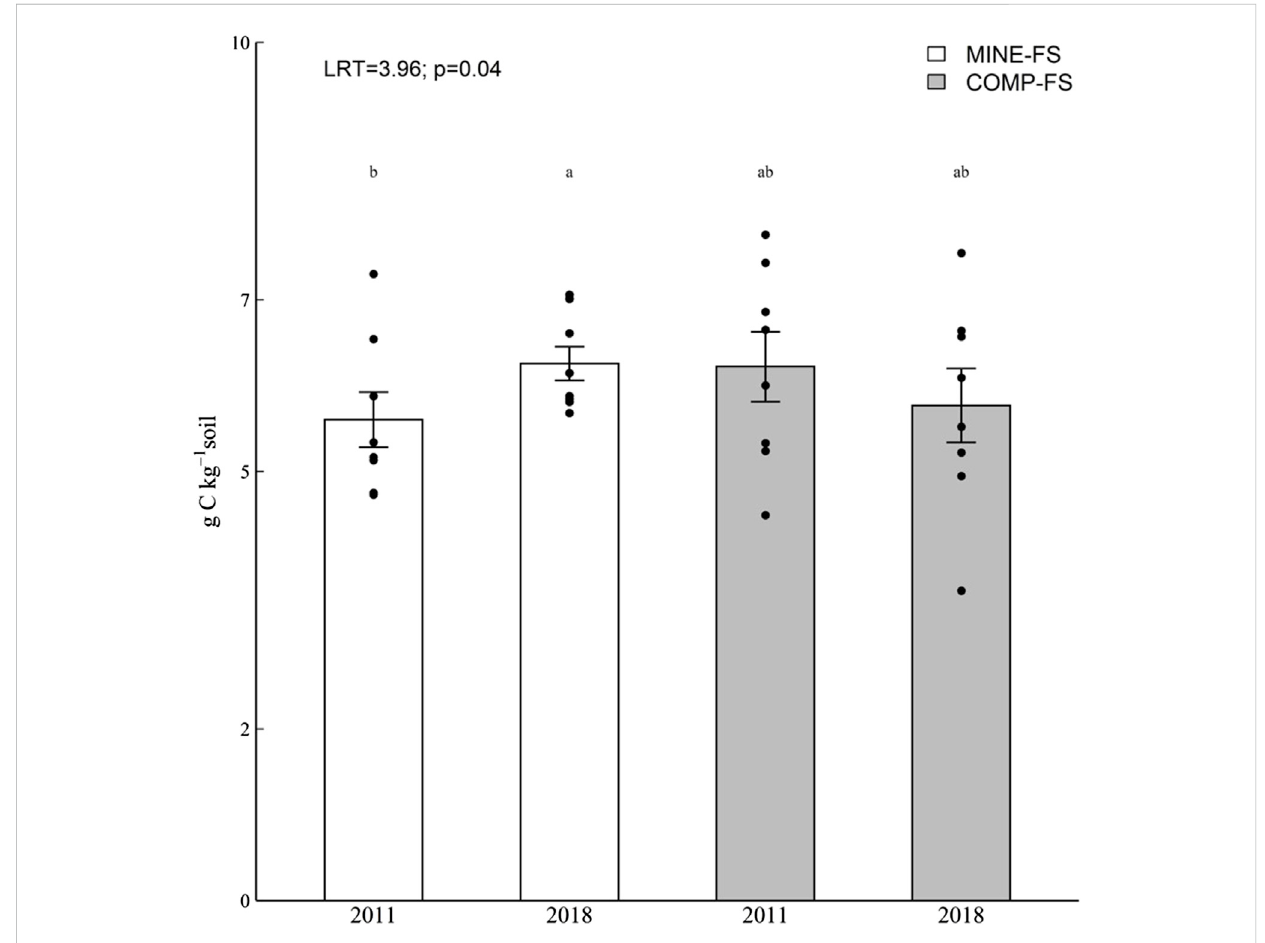
FIGURE 3 Interactive effects between fertility sources (mineral-MINE-FS and compost-COMP-FS) and years of sampling (2011 and 2018) on silt and clay fraction (SC < 53 μ m) at 0.30 – 0.60 m soil depth interval. Data are measured mean values ±SE ( n = 8 for fertility sources and years of sampling). Signi fi cance tests, using likelihood ratio test (LRT), are comparing models with or without the parameter of